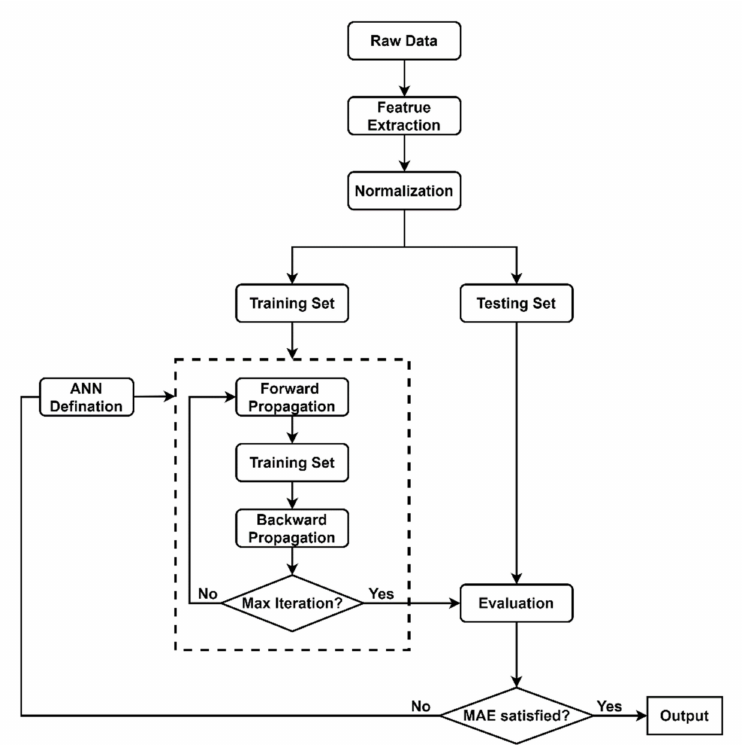
Figure 3. Flowchart of back-propagation neural networks